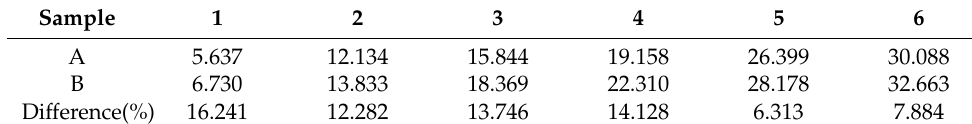
Table 1. The first six-order natural frequencies identified by modal test (Hz).